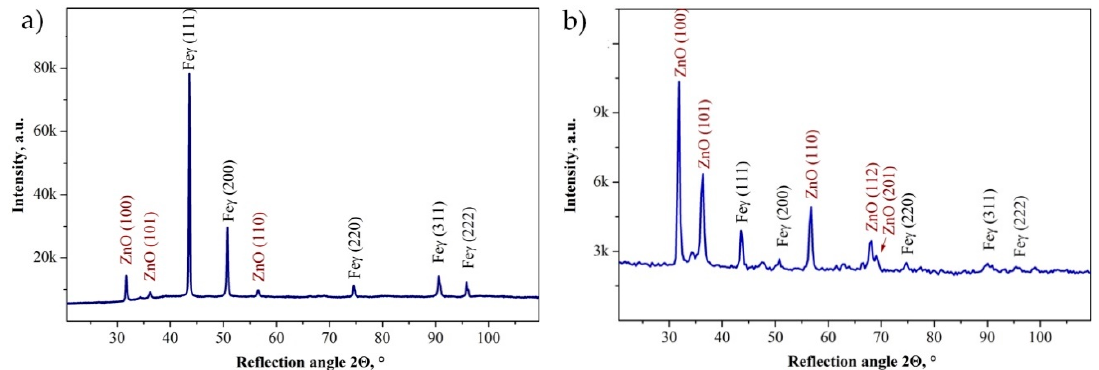
Figure 6. X-ray diffraction pattern of ZnO coating deposited on the Cr-Ni-Mo steel substrate obtained by the ( a ) Bragg–Brentano method and the ( b ) GIXRD method ( α = 1°).